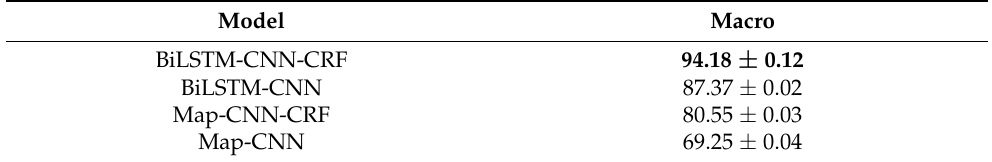
Table 5. Ablation study of the model. Bold shows best macro-average F1